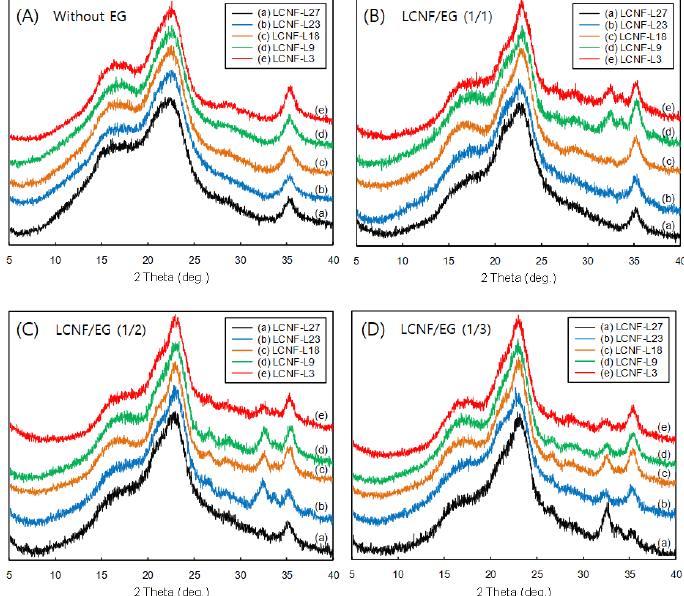
Figure 5. X-ray diffractograms of LCNFs with different lignin contents after enzymatic treatment Figure 5. X-ray di ff ractograms of LCNFs with di ff erent lignin contents after enzymatic treatment using using different EG contents; ( A ) without EG, ( B ) LCNF/EG (1/1), ( C ) LCNF/EG (1/2), ( D ) LCNF/EG di ff erent EG contents; ( A ) without EG, ( B ) LCNF / EG (1 / 1), ( C ) LCNF / EG (1 / 2), ( D ) LCNF / EG (1 / (1/3). Table 4. Crystallinity index (CrI) of the LCNFs with different lignin contents after enzymatic treatment using different EG contents (units: %).